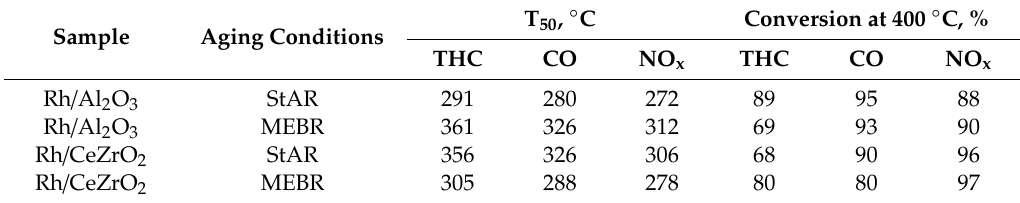
Table 3. Light-o ff parameters for the aged reference